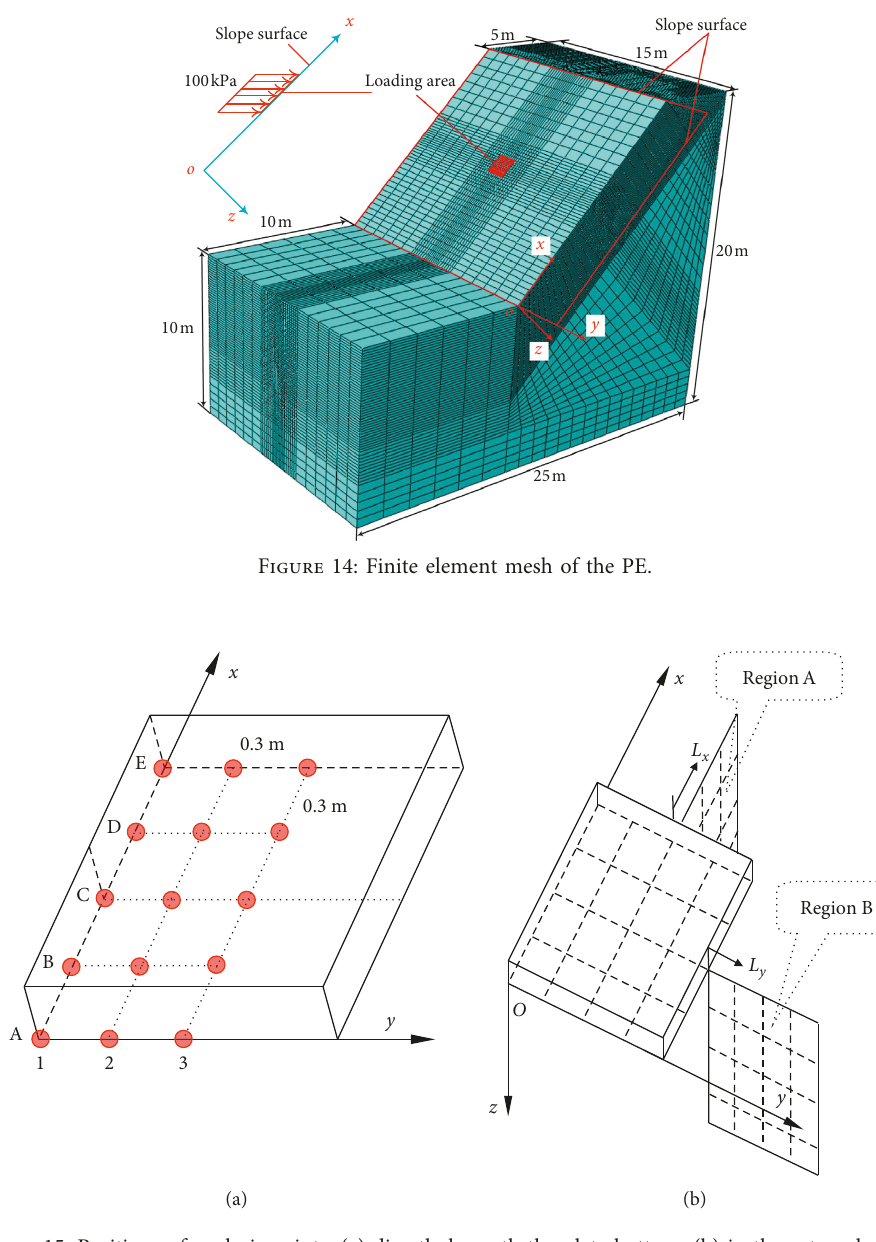
Figure 15: Positions of analysis points: (a) directly beneath the plate bottom; (b) in the external